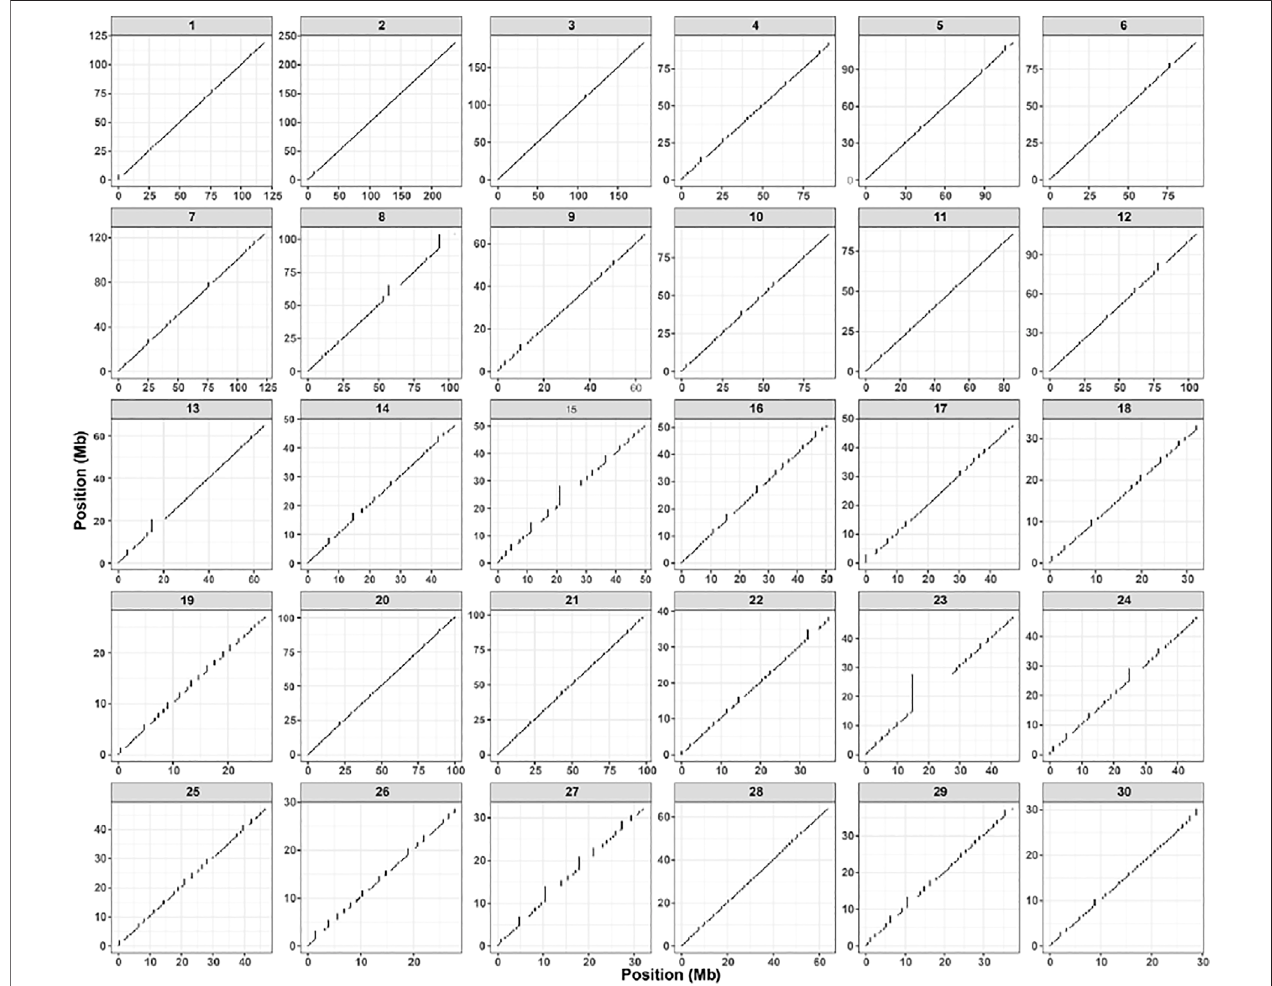
Figure S2 . The results demonstrated that the recombination rate shares the same patterns as the LD